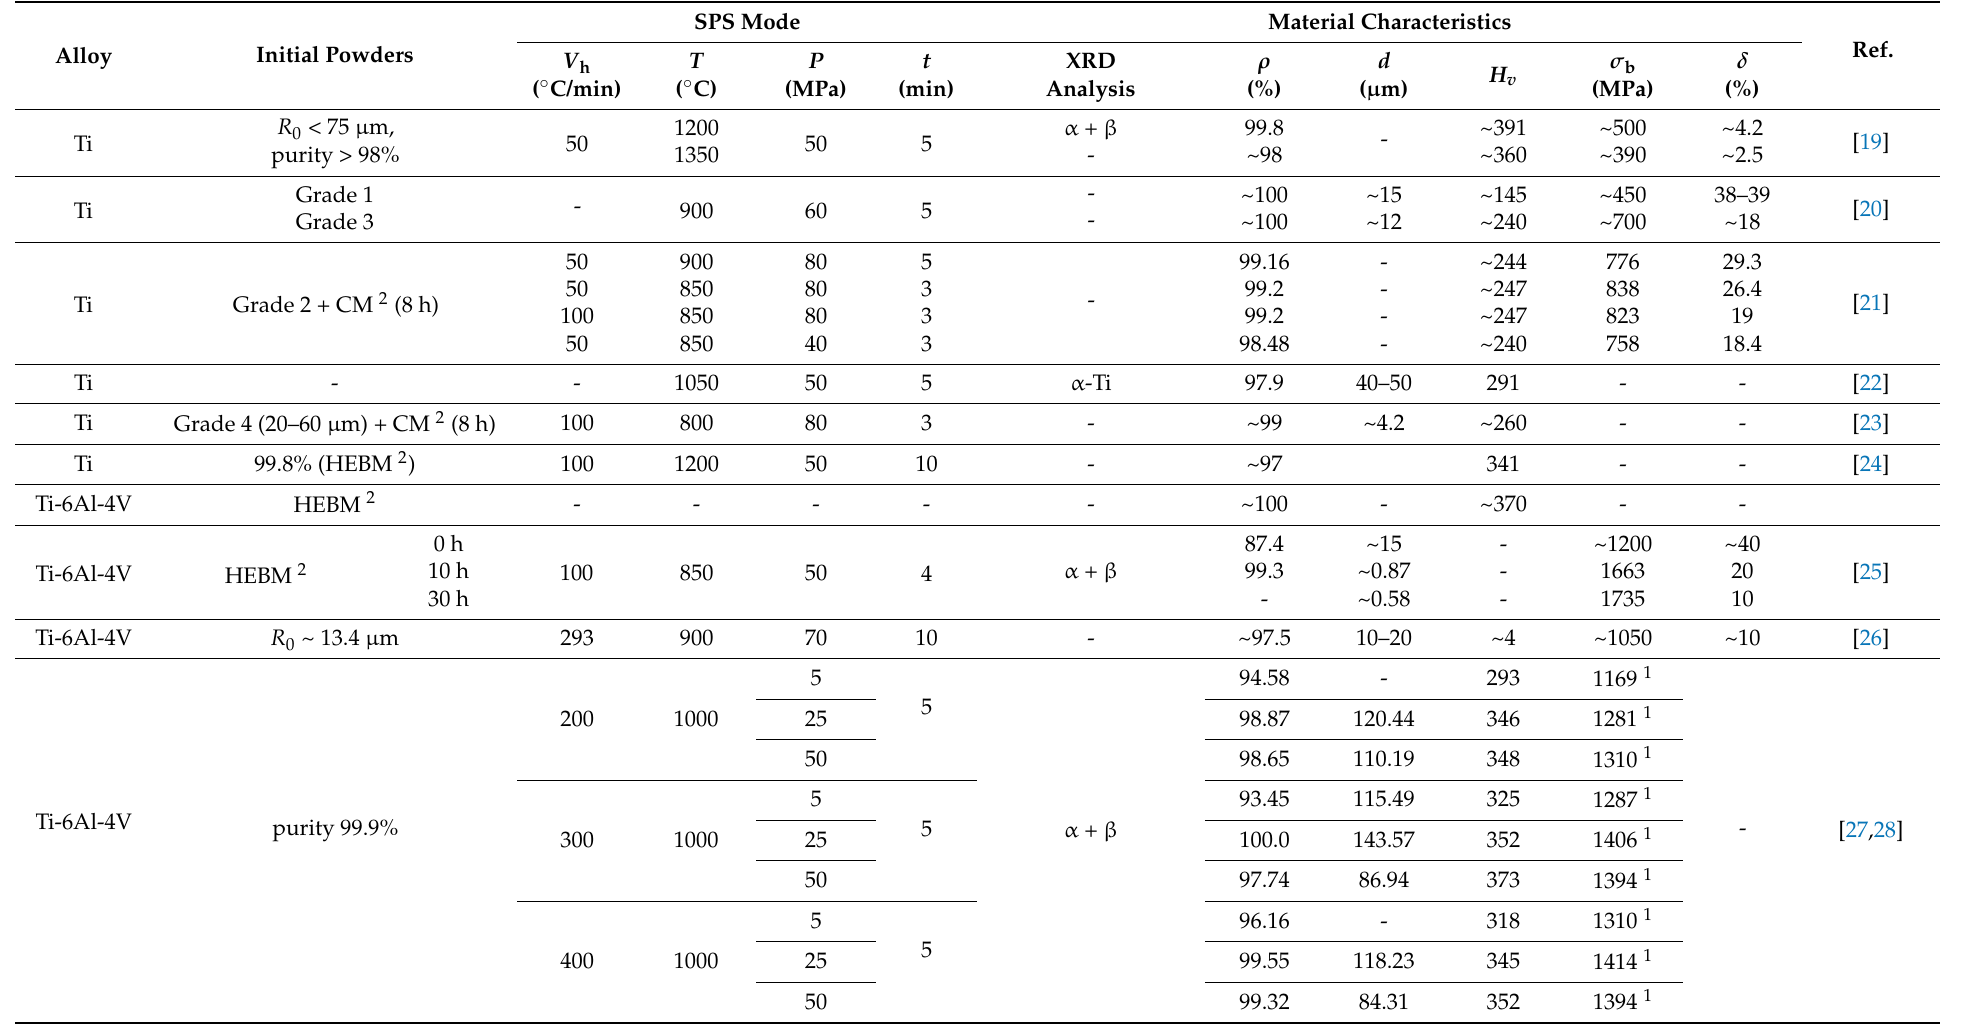
Table 1. Microstructure parameters and mechanical properties (hardness, tension testing results) of some Ti alloys obtained by